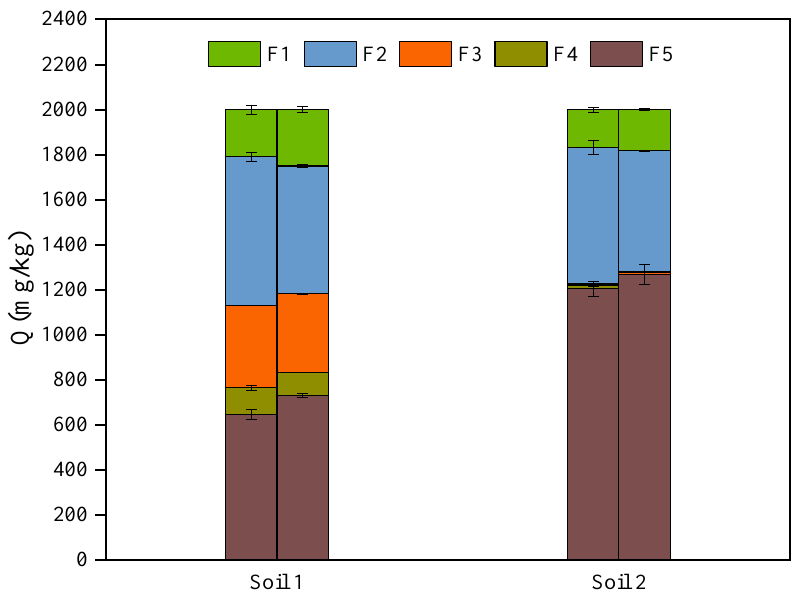
Figure 7. Sequential extraction by Tessier methods for soils after adsorption.